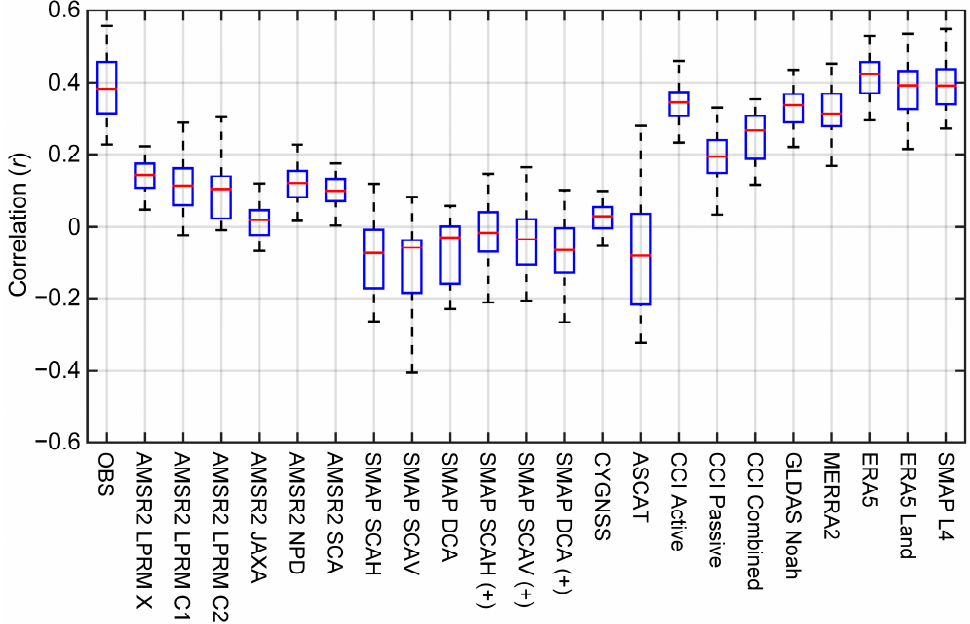
Figure 9. Correlations between daily precipitation amount and soil moisture change based on multiple products. Each boxplot shows the distribution of correlation coefficient values at the 20 stations, including the maximum, 75% quartile statistics, median, 25% quartile statistics and the